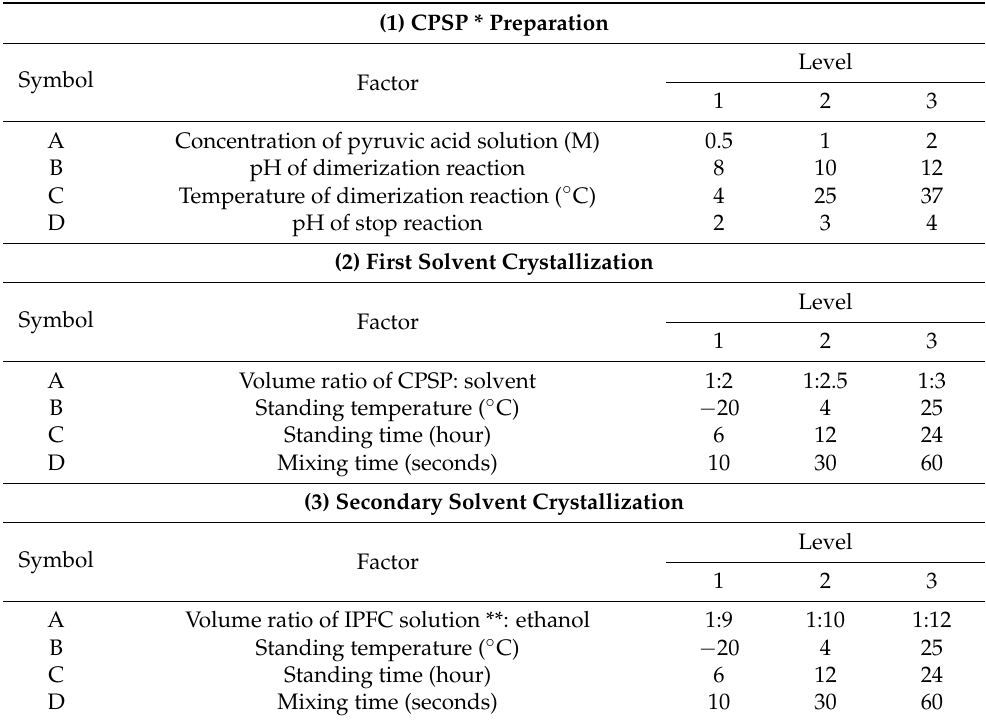
Table 1. The controllable factors and levels for the CPSP preparation, first solvent crystallization and secondary solvent